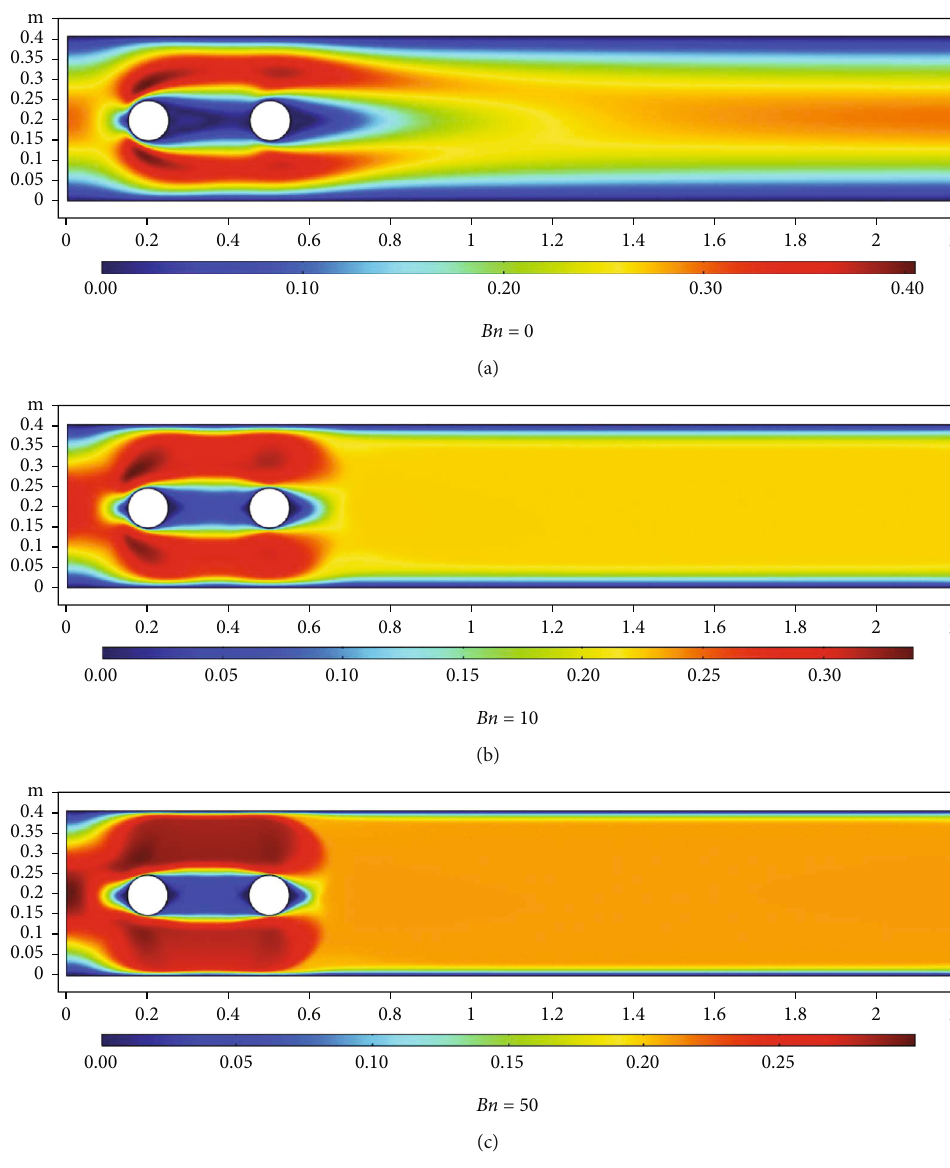
Figure 4: Velocity pro fi les for various Bn with G